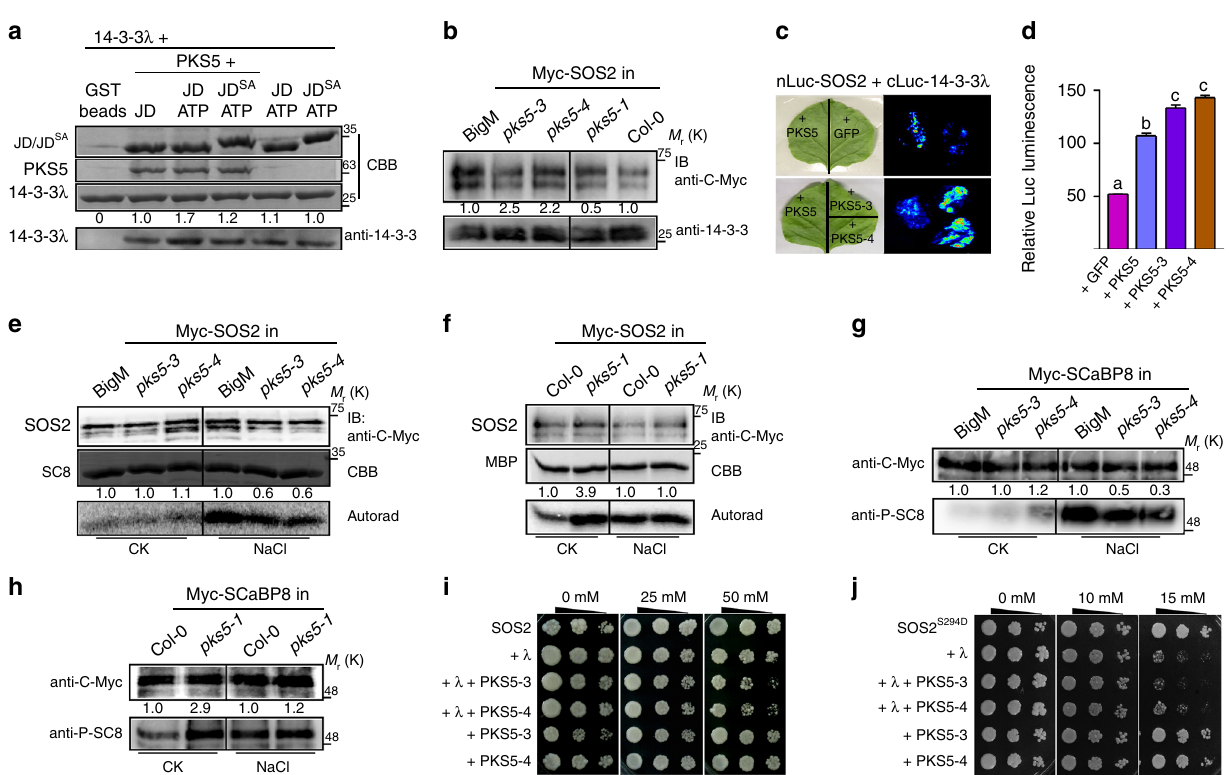
Fig. 2 PKS5 enhances the interaction between SOS2 and 14-3-3 proteins. a In vitro pull-down assay showing that PKS5 enhances the interaction between SOS2-JD and 14-3-3 λ following incubation with SOS2-JD in kinase buffer containing ATP. JD, SOS2-JD; JD SA , SOS2-JD S294A . b In vivo Co- immunoprecipitation assay showing that PKS5 enhances the interaction between SOS2 and 14-3-3 proteins. Myc-SOS2 was extracted with anti-C-Myc agarose from 10-day-old seedlings expressing Pro35S:6×Myc-SOS2 in BigM/ pks5-3 / pks5-4 /Col-0/ pks5-1 backgrounds and analyzed by immuno blotting with anti-C-Myc and anti-14-3-3 antibodies. c Luciferase complementation imaging assay showing that co-expression of PKS5/PKS5-3/PKS5-4 in N. benthamiana enhanced the interaction between SOS2 and 14-3-3 λ . d Relative fl uorescence analysis of ( c ) by ImageJ. Error bars represent SD; p ≤ 0.05, Student ’ s t -test; n = 3; signi fi cant differences are indicated by different lowercase letters. e , f In vitro kinase assay showing that PKS5 negatively regulates SOS2 activity. Myc-SOS2 was extracted using anti-C-Myc agarose from 10-day-old transgenic seedlings treated with or without 100 mM NaCl for 12 h. His-SCaBP8 (SC8) and MBP were used as the substrates and anti-C-Myc antibody was used for immunoblot analysis. g , h In vivo Co-immunoprecipitation assay showing that PKS5 negatively regulates the phosphorylation status of SCaBP8. Myc-SCaBP8 was extracted from 10-day-old seedlings expressing Pro35S:6×Myc-SCaBP8 in the BigM/ pks5-3 / pks5-4 /Col-0/ pks5-1 backgrounds treated or not with 100 mM NaCl for 12 h and analyzed by immunoblotting with anti-C-Myc and anti-phospho-SCaBP8Ser237 (anti-P-SC8) antibodies. i , j SOS recruitment system assays showing that PKS5 inhibits the SOS pathway by phosphorylating SOS2 Ser294 and enhances the interaction between SOS2 and 14-3-3 λ . Yeast cells expressing Arabidopsis SOS1 were co-